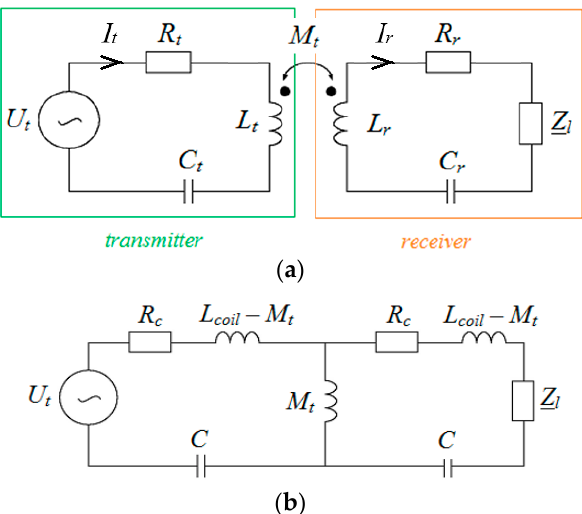
Figure 4. An analytical model with ( a ) a periodic cell, ( b ) a replacement circuit.